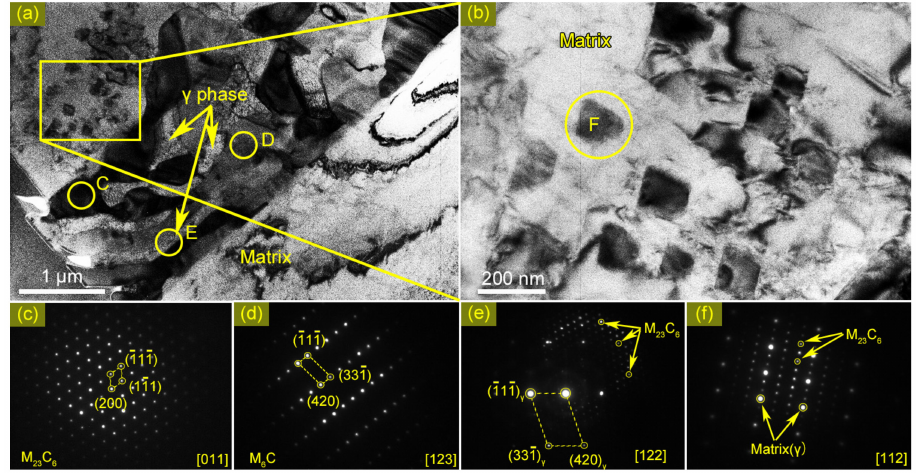
Figure 7. TEM images of network-shaped microstructure: ( a ) bright field; ( b ) bright-field image of fine precipitates; ( c )-( e ) are SAED patterns of zones C, D, and E marked in ( a ), respectively; ( f ) SAED pattern of fine precipitates marked by F in ( b ). Table 4. Chemical compositions measured by EDX in TEM: M 23 C 6 (C in Figure 7a) and M 6 C (D in Figure 7a) in a network-shaped structure and M 23 C 6 in fine precipitates (F in Figure 7a) (wt %).